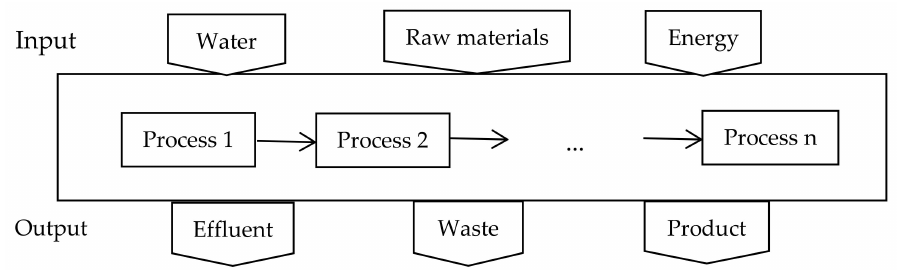
Figure 2. System boundary of ethanol industrial water footprint.